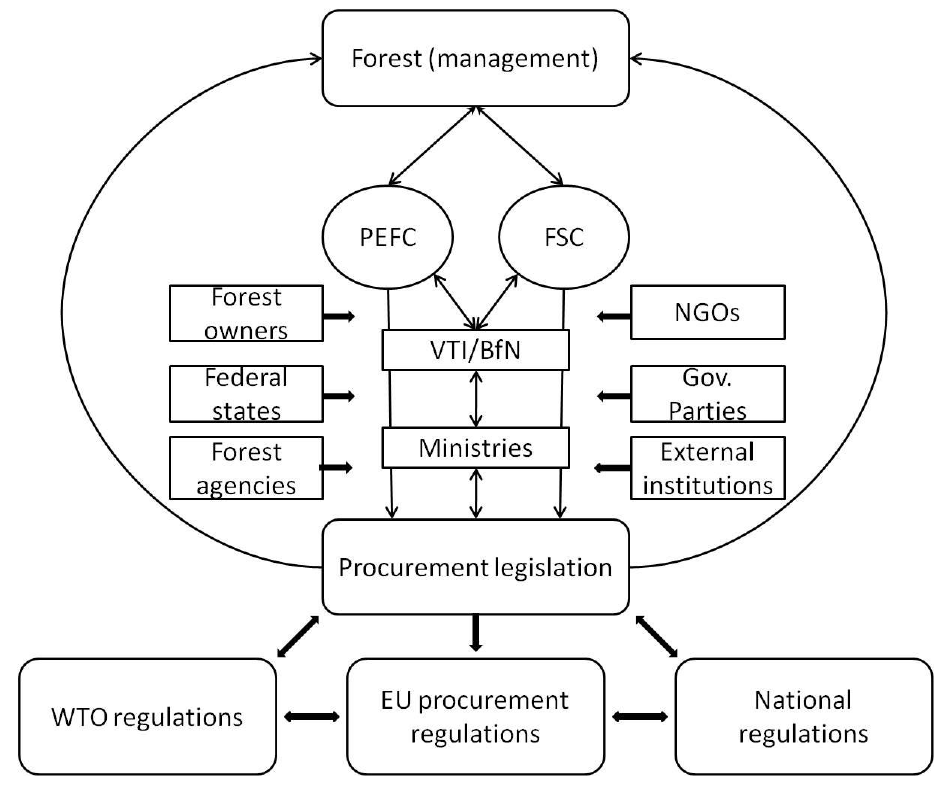
Figure 1. Discourse on the integration of the forest certification schemes into German (and EU) procurement legislation. Entities displayed in boxes are not enclosed systems but